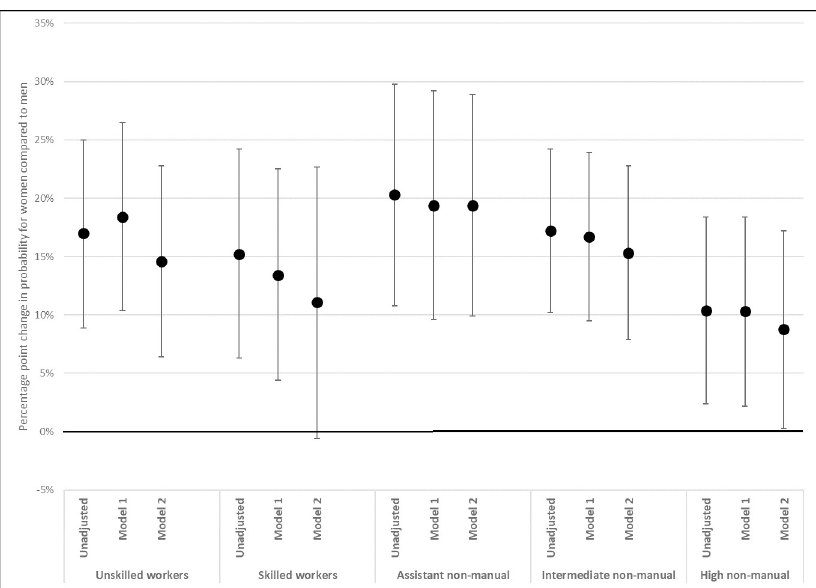
Fig 7. Gender differences in probability of psychiatric distress, by class. Coefficients from class-separate LPM. Coefficients (for woman = 1) interpreted as percentage point change in probability for psychiatric distress. From class- separate linear probability models, with 95% confidence intervals (Table H in S4 Appendix). Unadjusted model regresses psychiatric distress on gender, separately by class. Stepwise adjustment for physical working conditions (Model 1) and psychosocial working conditions (Model 2). Both unadjusted and adjusted models are controlled for age and age^2.